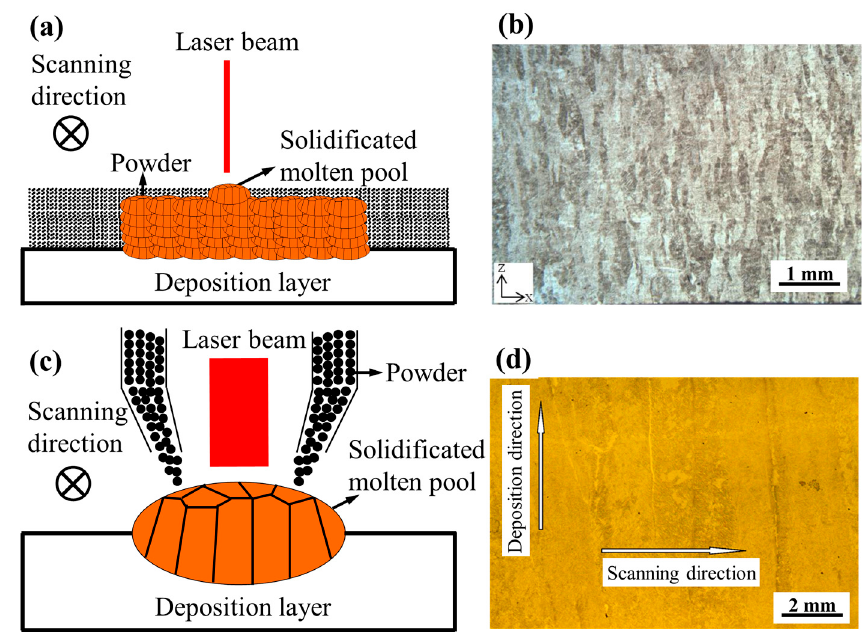
Figure 1. ( a ) Schematic of selective laser melting (SLM) process ( ⊗ represents that the scanning direction is perpendicular into the plane.); ( b ) Microstructure of Ti-6Al-4V alloy by SLM [10]; ( c ) Schematic of laser melting deposition (LMD) process and ( d ) Microstructure of Ti-6Al-4V alloy by LMD [11].